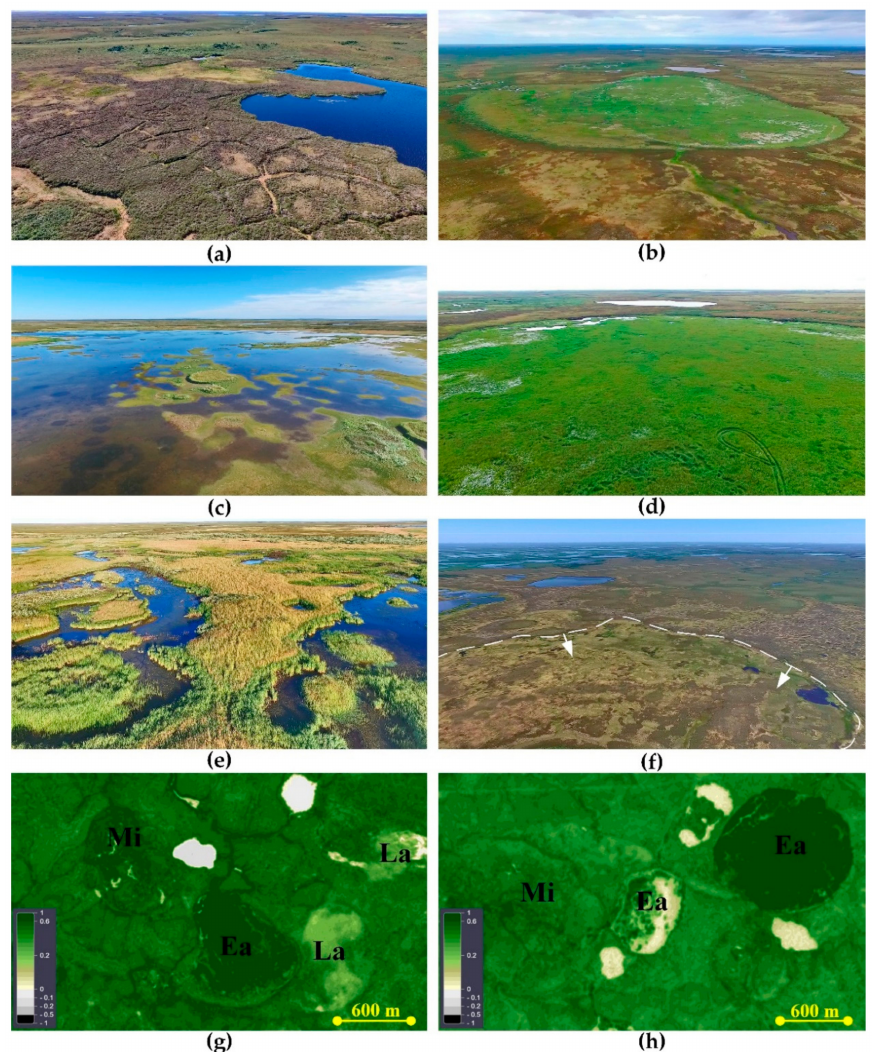
Figure 13. Landscape and NDVI values in northern part of the Pur-Taz interfluve. ( a ) Tundra and polygonal frozen bog; ( b, c, d ) the early khasyrey; ( e ) mid khasyrey; ( f ) late khasyrey; ( g ) and ( h ) NDVI values from modified Copernicus Sentinel data (( g )—08.22.2018 and ( h )—20.07.2019), processed by the EO Browser (abbreviations for succession stages see Figure